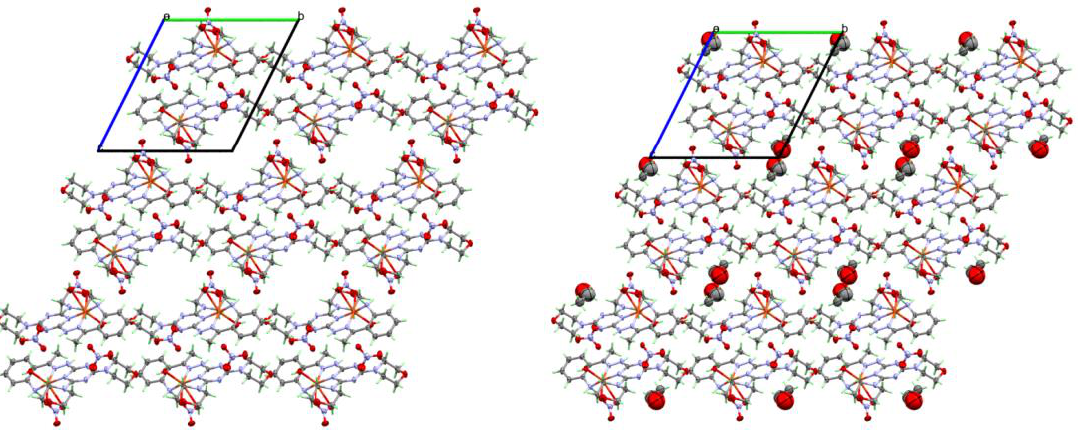
Figure 5. The packing structures of complex 1 with ( left ) and without ( right ) the disordered ethanol molecule.